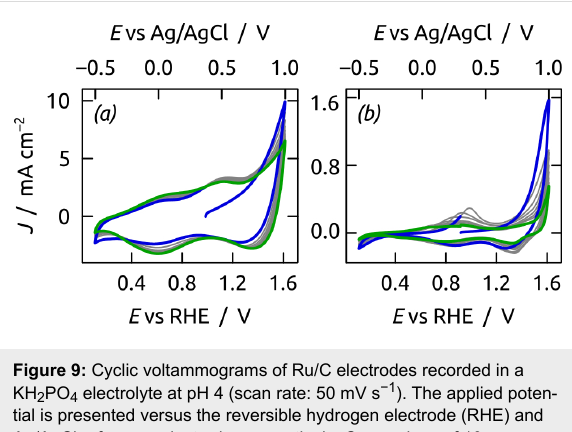
Figure 9: Cyclic voltammograms of Ru/C electrodes recorded in a KH 2 PO 4 electrolyte at pH 4 (scan rate: 50 mV s − 1 ). The applied